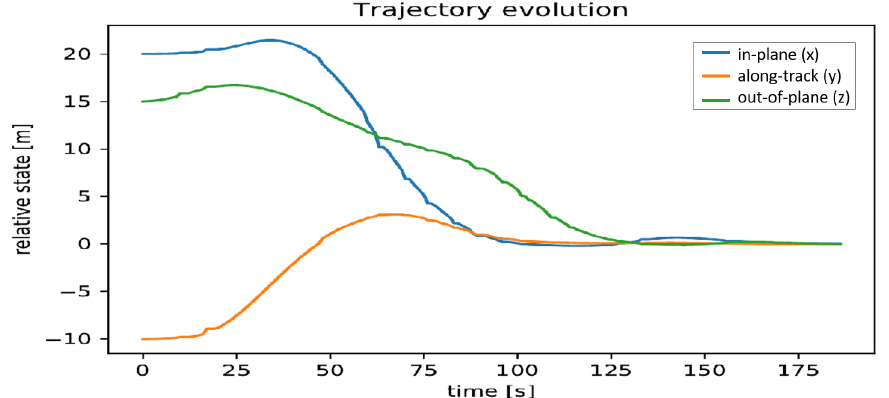
Figure 18. Control performance of the networked formation control of satellite 3 over a network with Markovian network characteristics with failure of the controller node of satellite 3 at time t = 35 s. The remaining control inputs of length N min stored at the actuator successfully bridge the time until the control task is assigned to a new